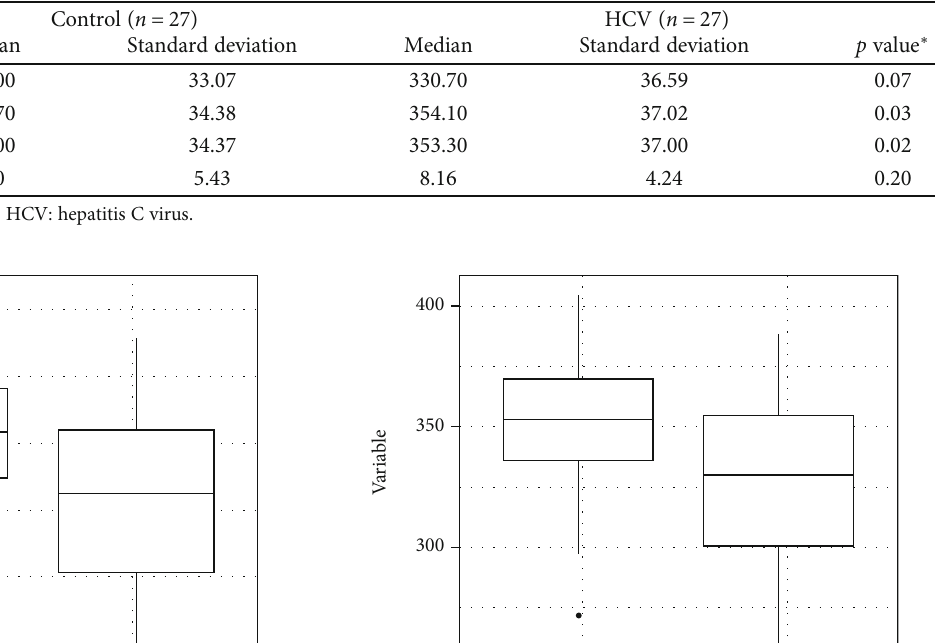
Table 7: Descriptive statistics of the cognitive evoked potential